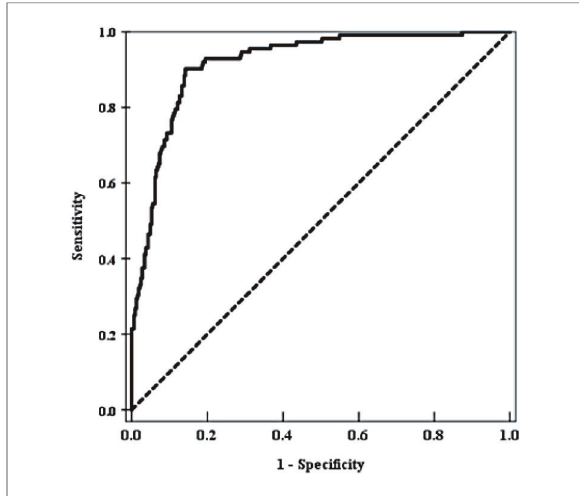
FIGURE 2 The distinguishing ability of models was evaluated by ROC